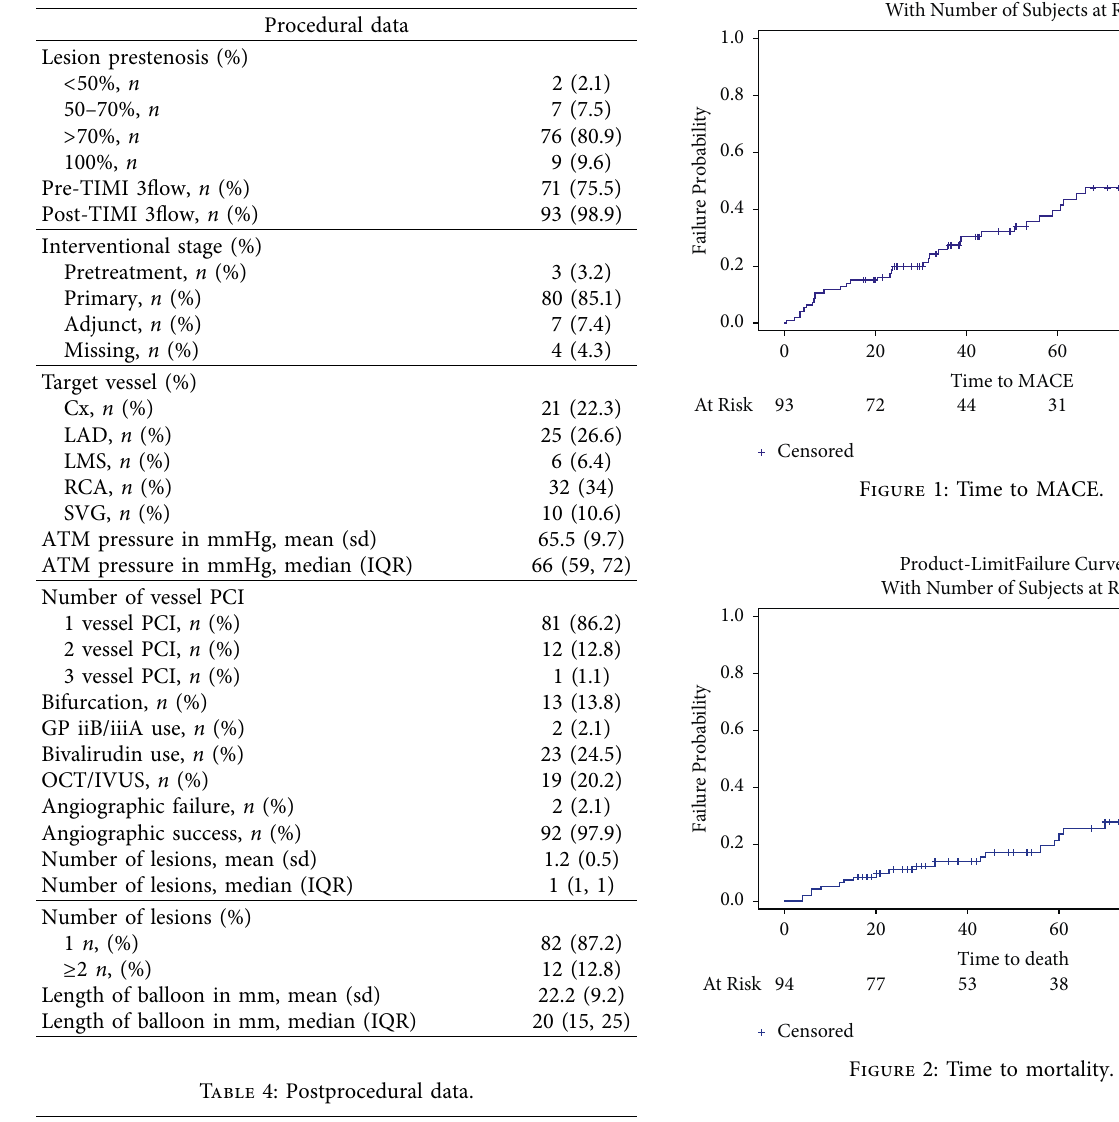
Table 3: Procedural data.